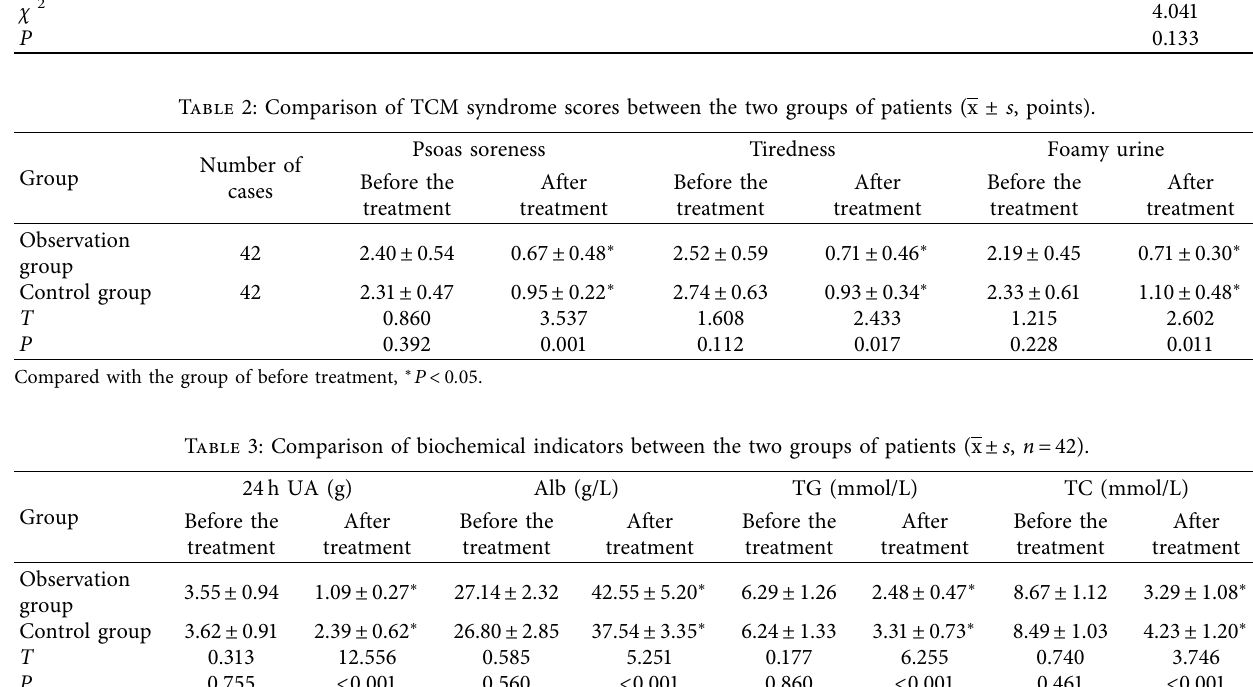
Table 4: Comparison of immune function between two groups of patients (x ± s , n � 42). After Before the treatment treatment treatment